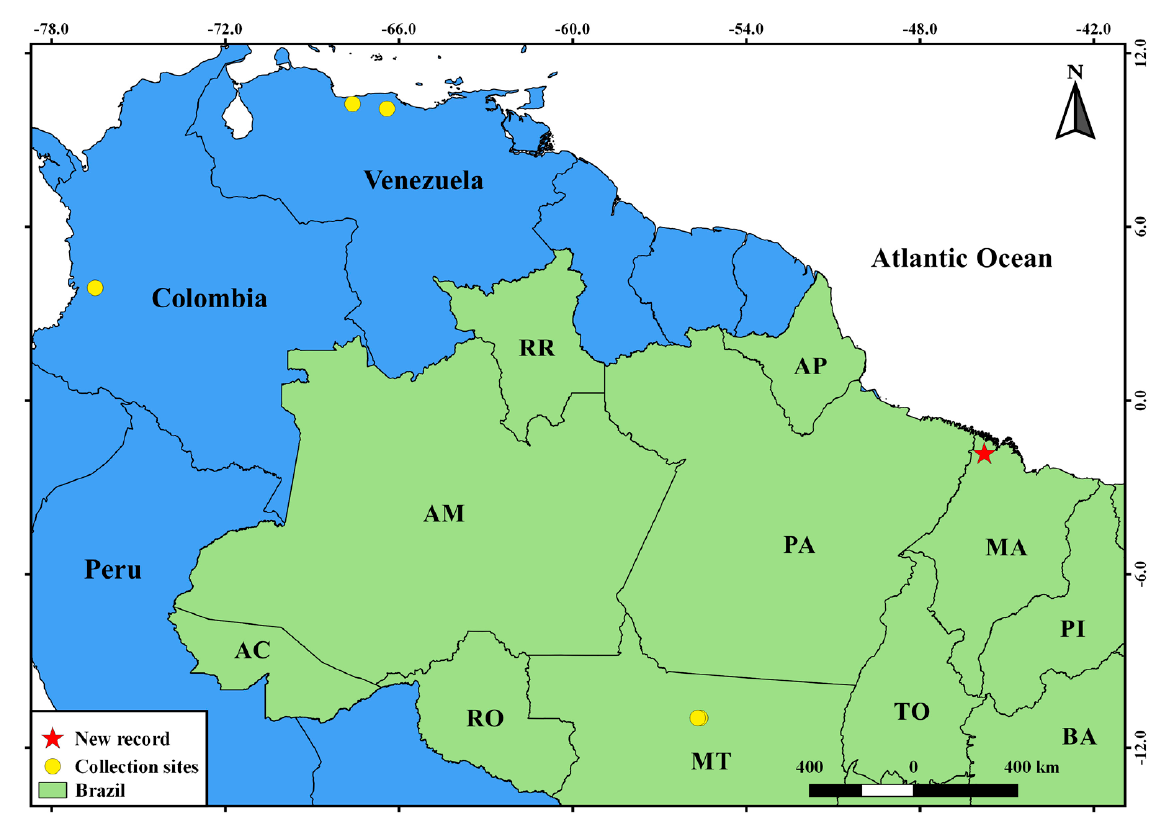
Figure 1. Collection sites of Maxillaria aureoglobula Christenson in South America, highlighting the location of the new record in the state of Maranhão,